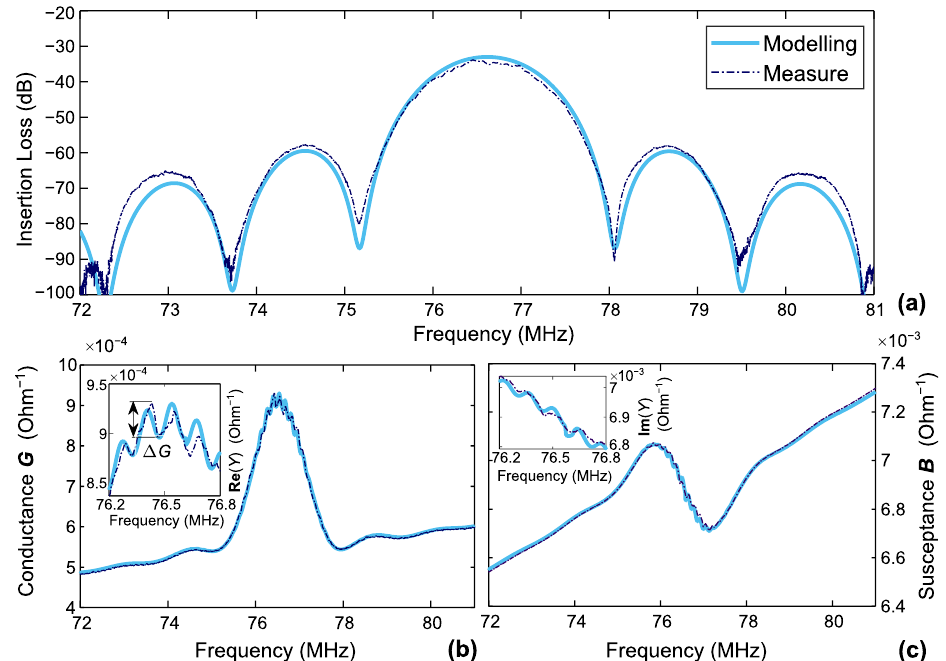
Figure 5. Simulated (solid lines) and measured (dash-dot lines) electric response for 1.5 µm Parylene- covered sensor: ( a ) insertion loss; ( b ) conductance; ( c )